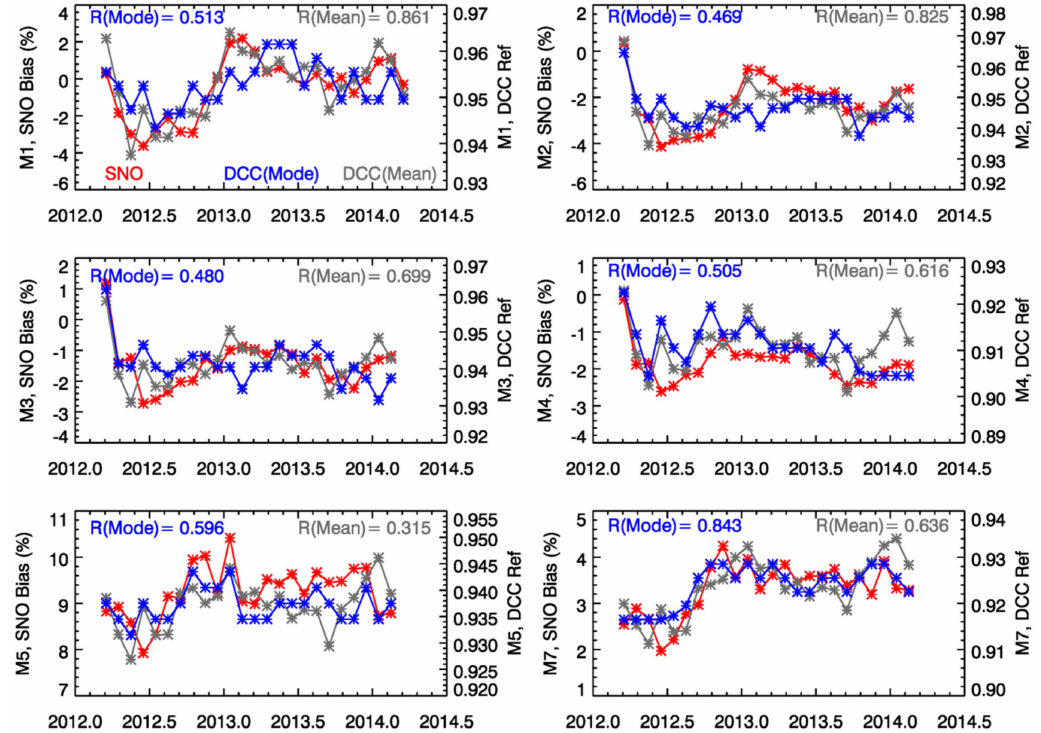
Figure 9. Comparison of DCC mode and mean time series and SNO-x bias time series (the DCC mean time series were adjusted using constant offsets to match the DCC mode time series to facilitate visual